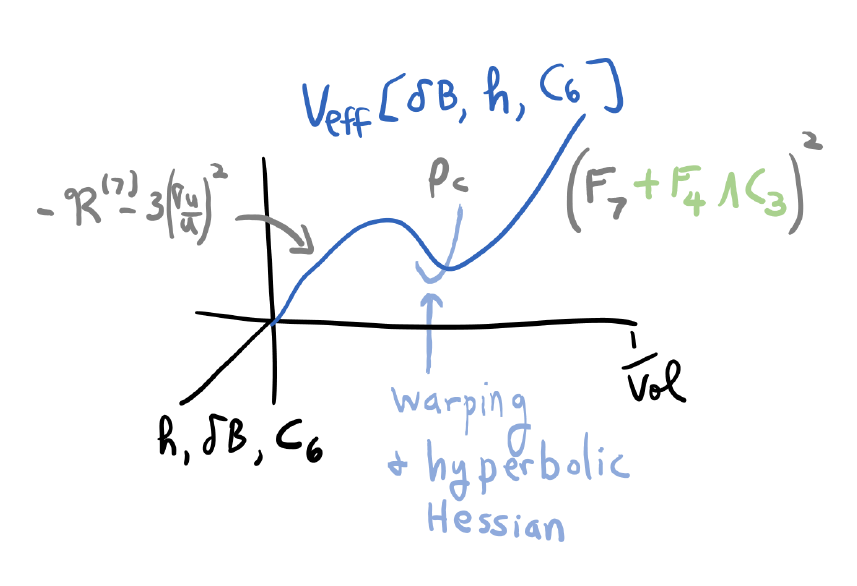
Figure 1: Schematic of our stabilization mechanism. The overall volume is stabilized by the indicated three-term mechanism involving curvature (including warp factor gradients), Casimir energy, and flux, in a regime of large radius control (5.88).